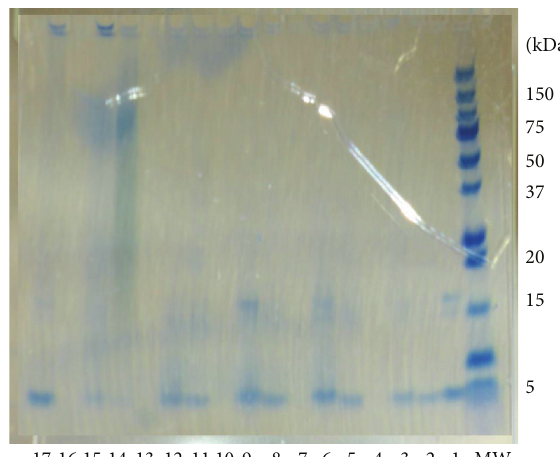
Figure 1: 15% SDS-PAGE of the products of amyloid 𝛽 (A 𝛽 ) (1– 42) incubation with extracts from plant sprouts (PSE). SDS-PAGE illustrating the inhibition effect of PSE on A 𝛽 (1–42). Lanes (from right to left) indicating the electrophoretic migration of A 𝛽 (1– 42) in the absence of PSE and in the presence of PSE. 1: A 𝛽 (1– 42); 2: cold water- (CW-) buckwheat sprout (BWS); 3: hot water- (HW-) buckwheat sprout (BWS); 4: methanol- (MH-) buckwheat sprout (BWS); 5: CW-red cabbage sprout (RCS); 6: HW-red cabbage sprout (RCS); 7: MH-red cabbage sprout (RCS); 8: CW-broccoli sprout (BS); 9: HW-broccoli sprout (BS); 10: MH-broccoli sprout (BS); 11: CW-brussels sprout (BRS); 12: HW-brussels sprout (BRS); 13: MH-brussels sprout (BRS); 14: CW-Japanese butterbur (JBB); 15: HW-Japanese butterbur (JBB); 16: MH-Japanese butterbur (JBB); 17: epigallocatechin gallate (EGCG). MW shows a molecular weight marker. All tested samples were analyzed by 15% Tris-HCl-SDS- PAGE, followed by Quick-CBB PLUS staining, as described in the experimental